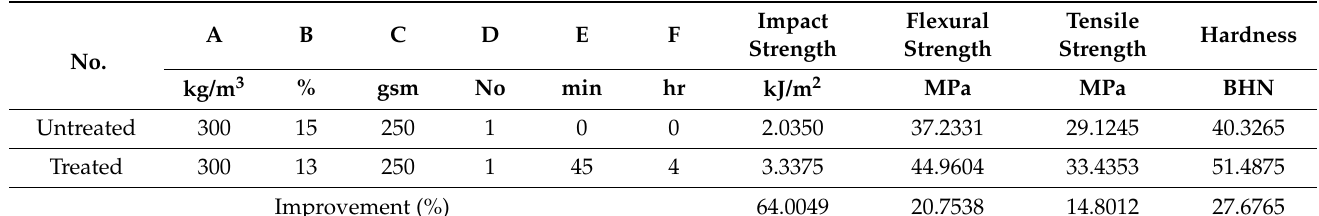
Table 11. Optimised response in comparison with untreated woven-jute/saw-dust polyester composite (maximised